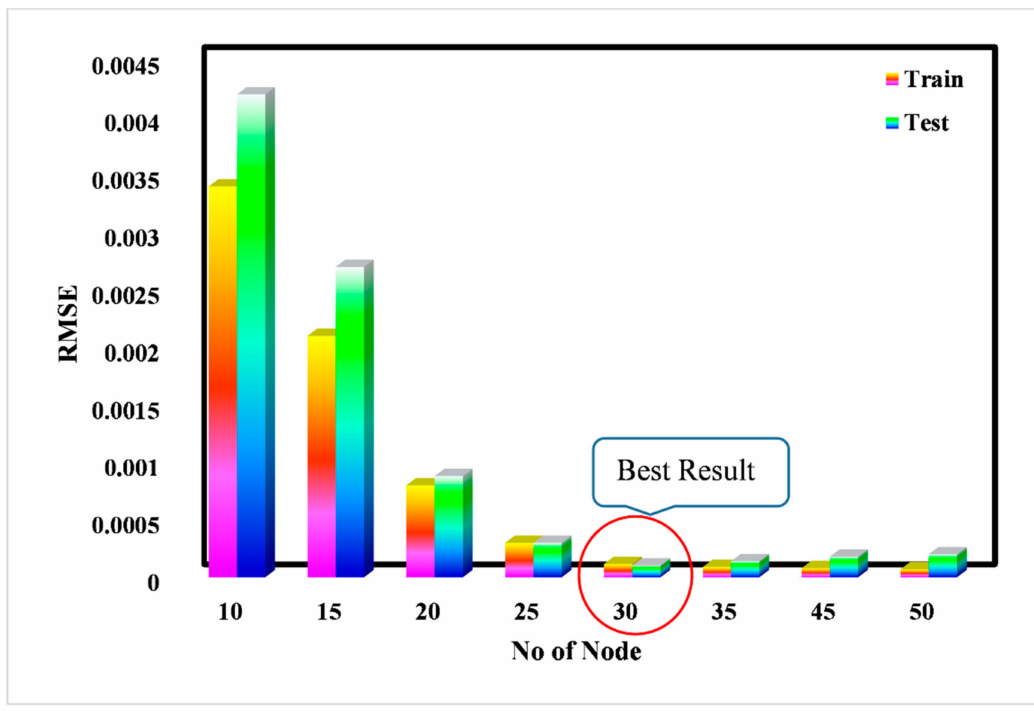
Figure 2. Obtaining optimum structure of proposed